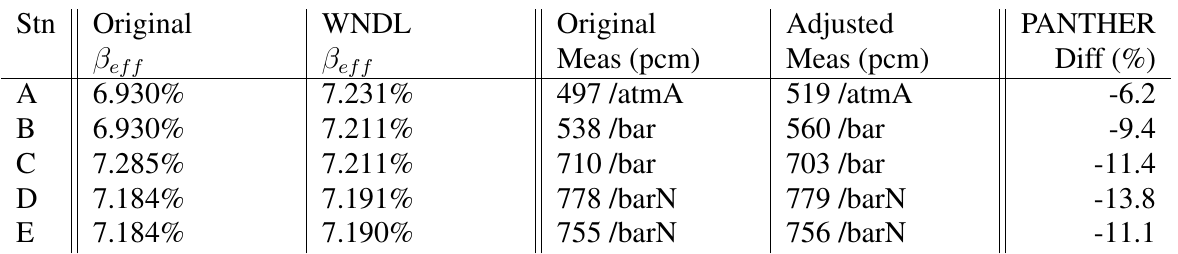
Later tests used ’inverse kinetics’ to deduce reactivity during a continuous nitrogen pressure